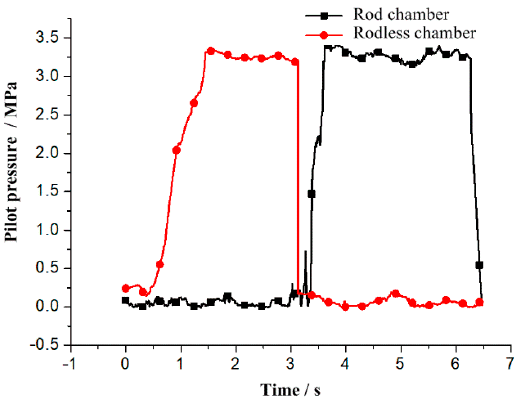
Figure 14. Pilot pressure curves of the two chambers of the arm cylinder.